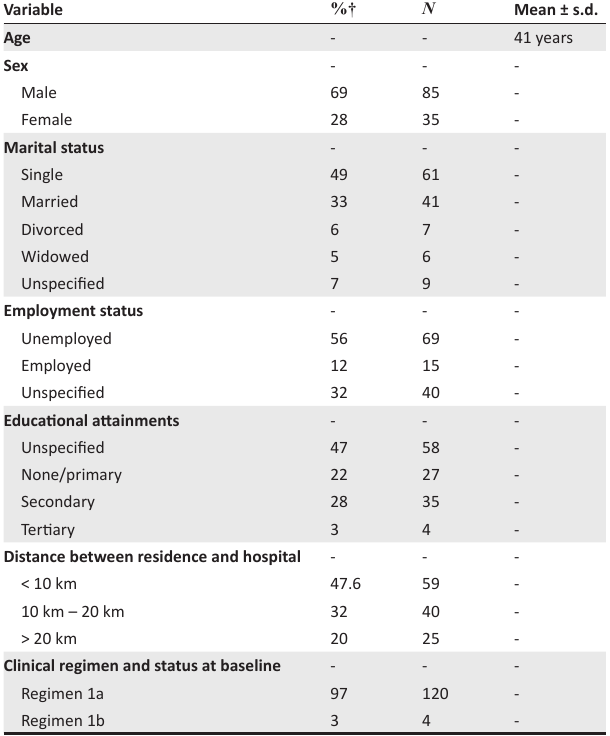
TABLE 1: Patients’ socio-demographic characteristics and treatment regimen.